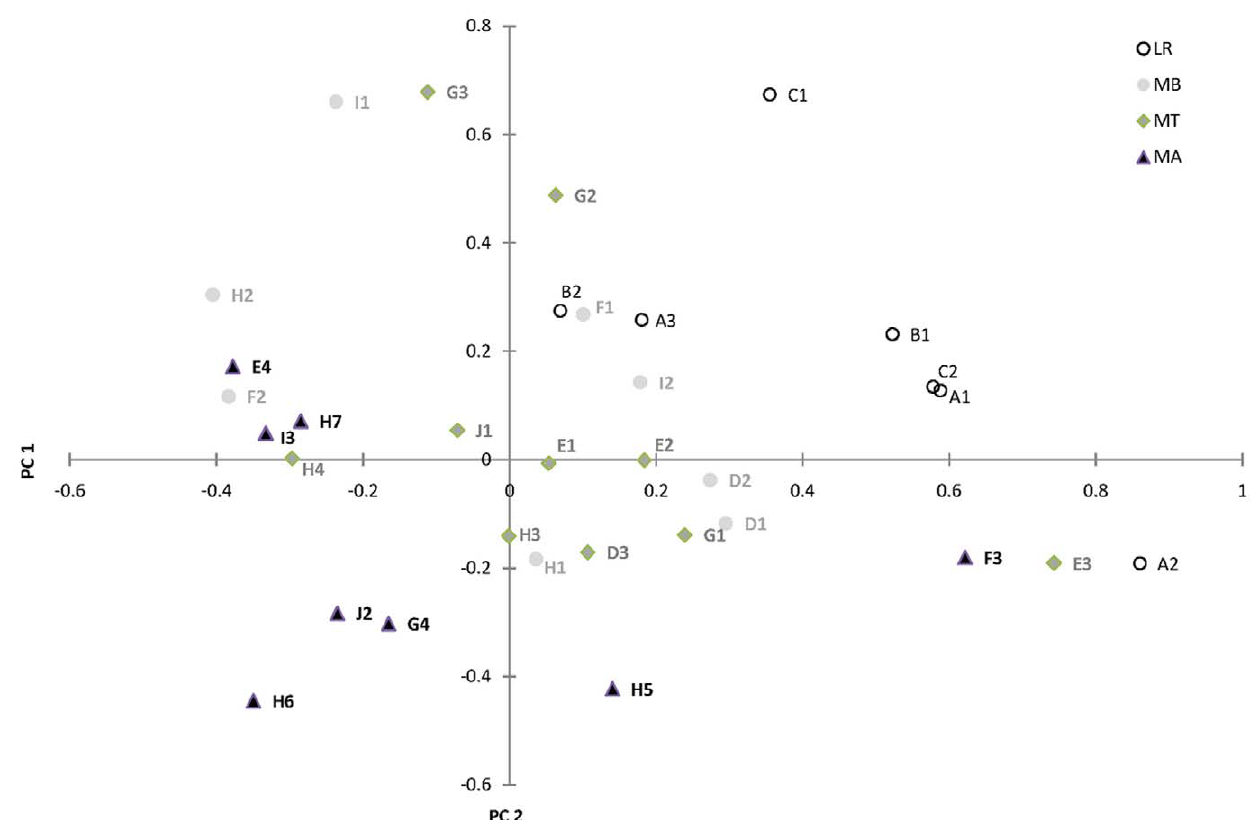
Figure 6. Genetic relationship between Agabus bipustulatus populations and altitudinal levels in northern Sweden. Genetic relationship was analysed from nine enzyme systems (not including the a -Gpdh loci) with a principle component analysis (PCA). The first significant component from the PCA separated the two ecotypes with an overlap of the populations at the tree line and explained 36.0% of the total genetic N variation. The second significant axis of the PCA explained 17% of the genetic variation. Populations from lowland region ( # ); mountain region ), at the tree line ( m ) and above ( & ). The deviating population above the tree line to the right corner is Ga¨utavardo (F3) from the F below tree line ( area in the mountain region. Population numbers are given according to table